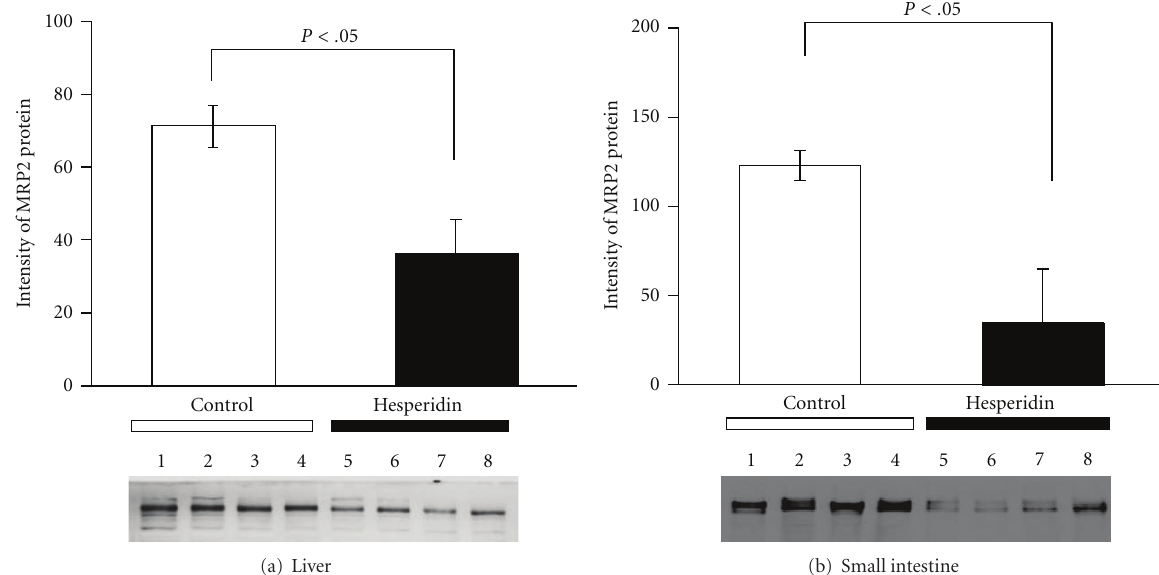
Figure 5: E ff ect of hesperidin on Mrp2 protein levels in both the liver (a) and small intestine (b) in rats. Hesperidin instead of OJ was given to 8-week-old male Sprague-Dawley rats according to the same schedule and volume as in the OJ study. Tap water was also given as a control. The hesperidin solution was prepared at a concentration of 79mg per 100mL of tap water. The small intestine and liver were removed 1h after the last ingestion of hesperidin. Western blot analysis was performed using the same methods as in the in vitro OJ study. P < . 05